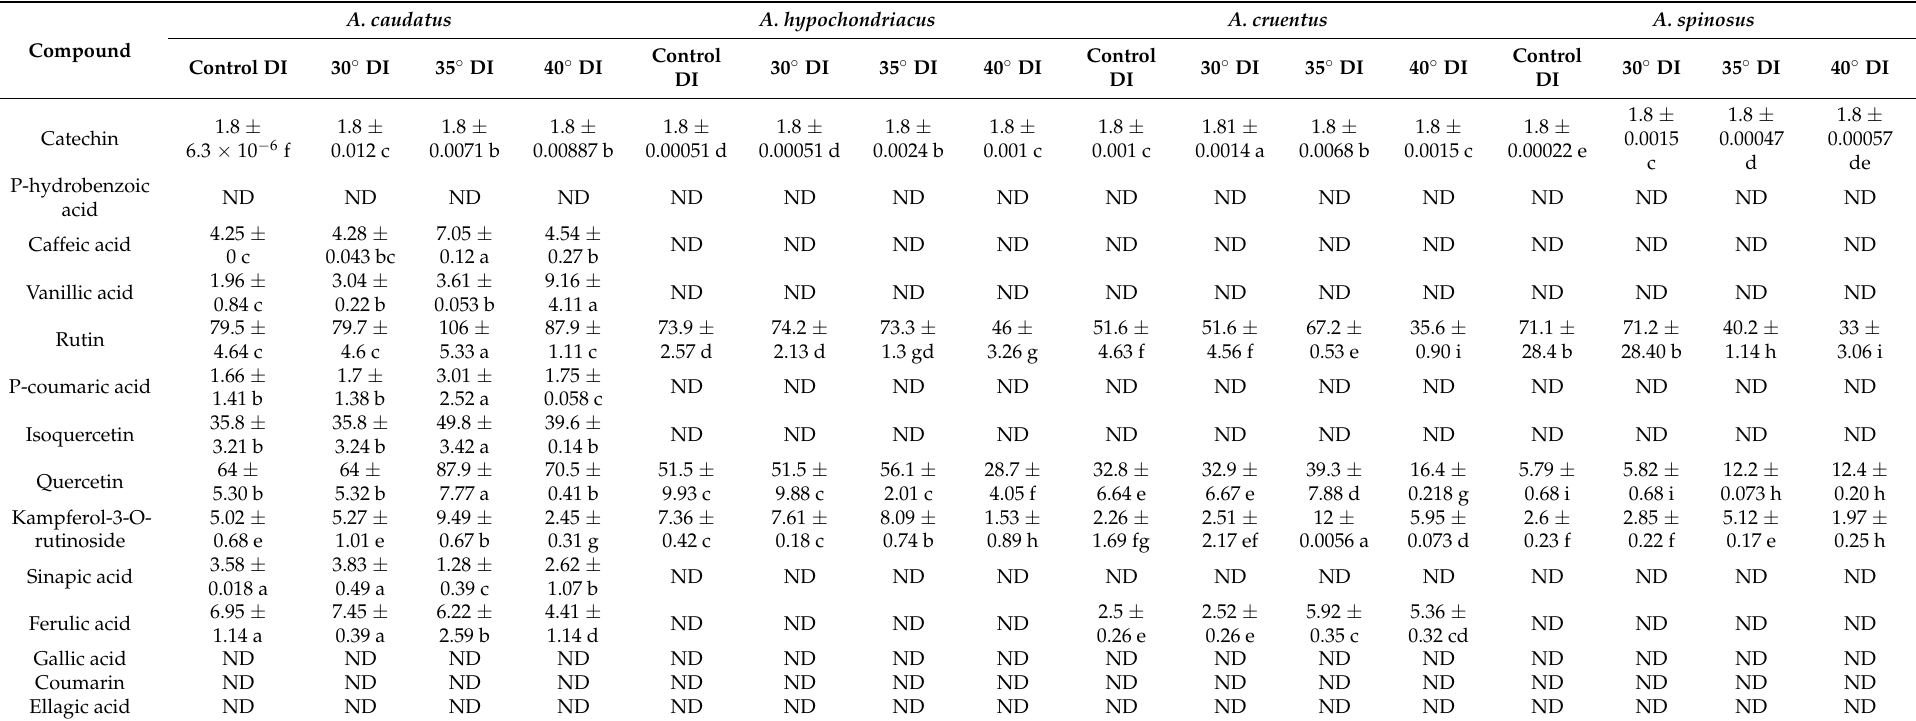
Table 3. Individual phenolic and flavonoids compounds contents detected in MeOH leaves extracts of Amaranthus species treated with different temperature regimes under DI condition ( µ g/g DW). ND (not detected). Data are shown as mean ± standard deviation and different letters in the same row indicate significant differences ( p ≤